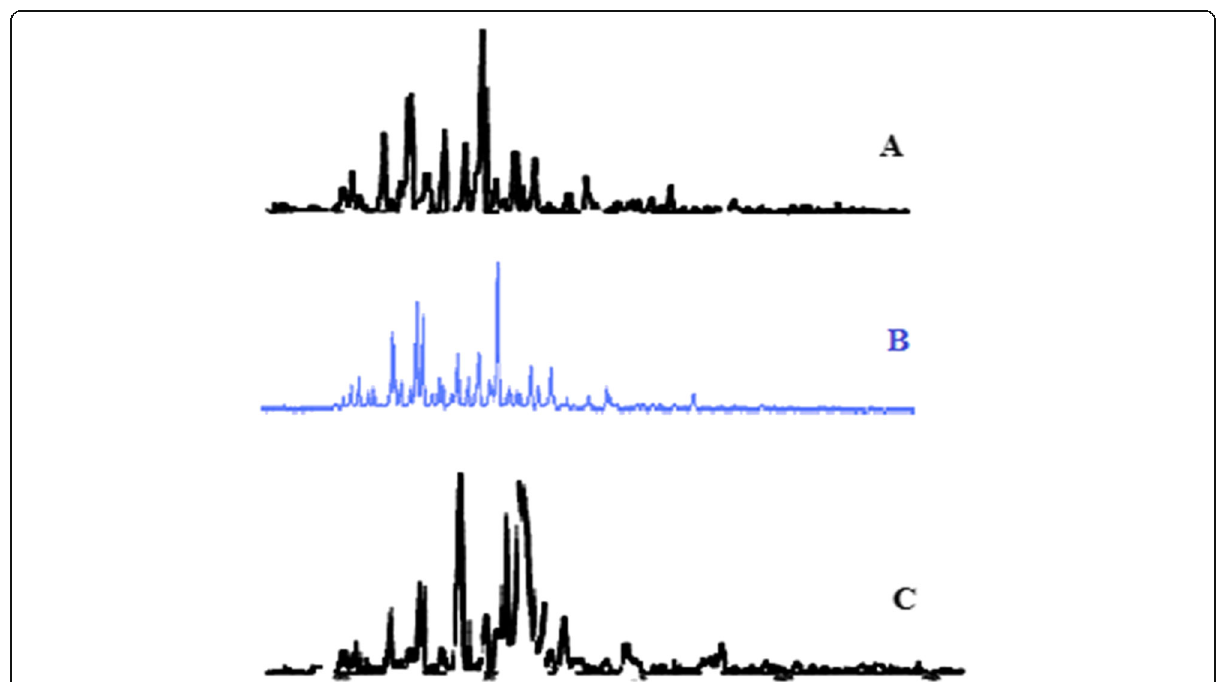
Fig. 6 PXRD spectra of ( a ) Pure Fenofibrate and ( b ) Pure Fenofibrate after Ball milling ( c ) Fenofibrate Co-Crystal